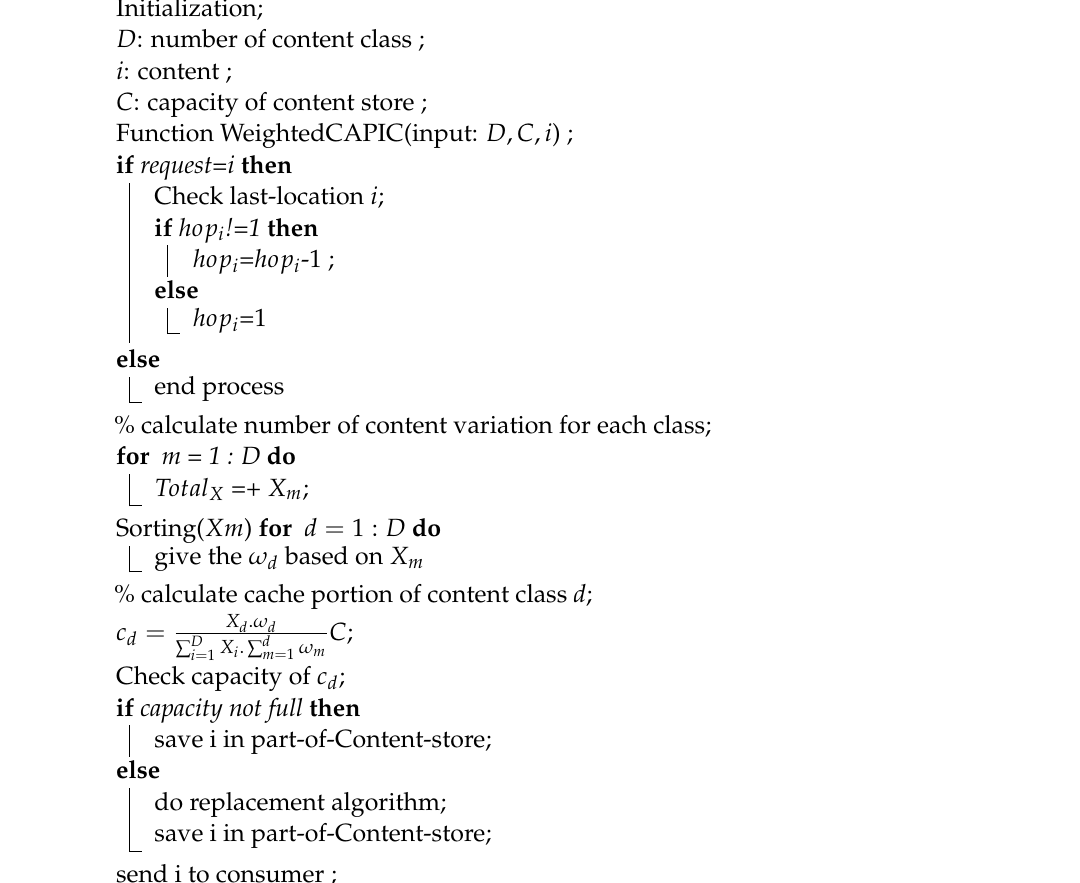
Figure 5. Network cache hit ratio for various level of request. Algorithm 1: